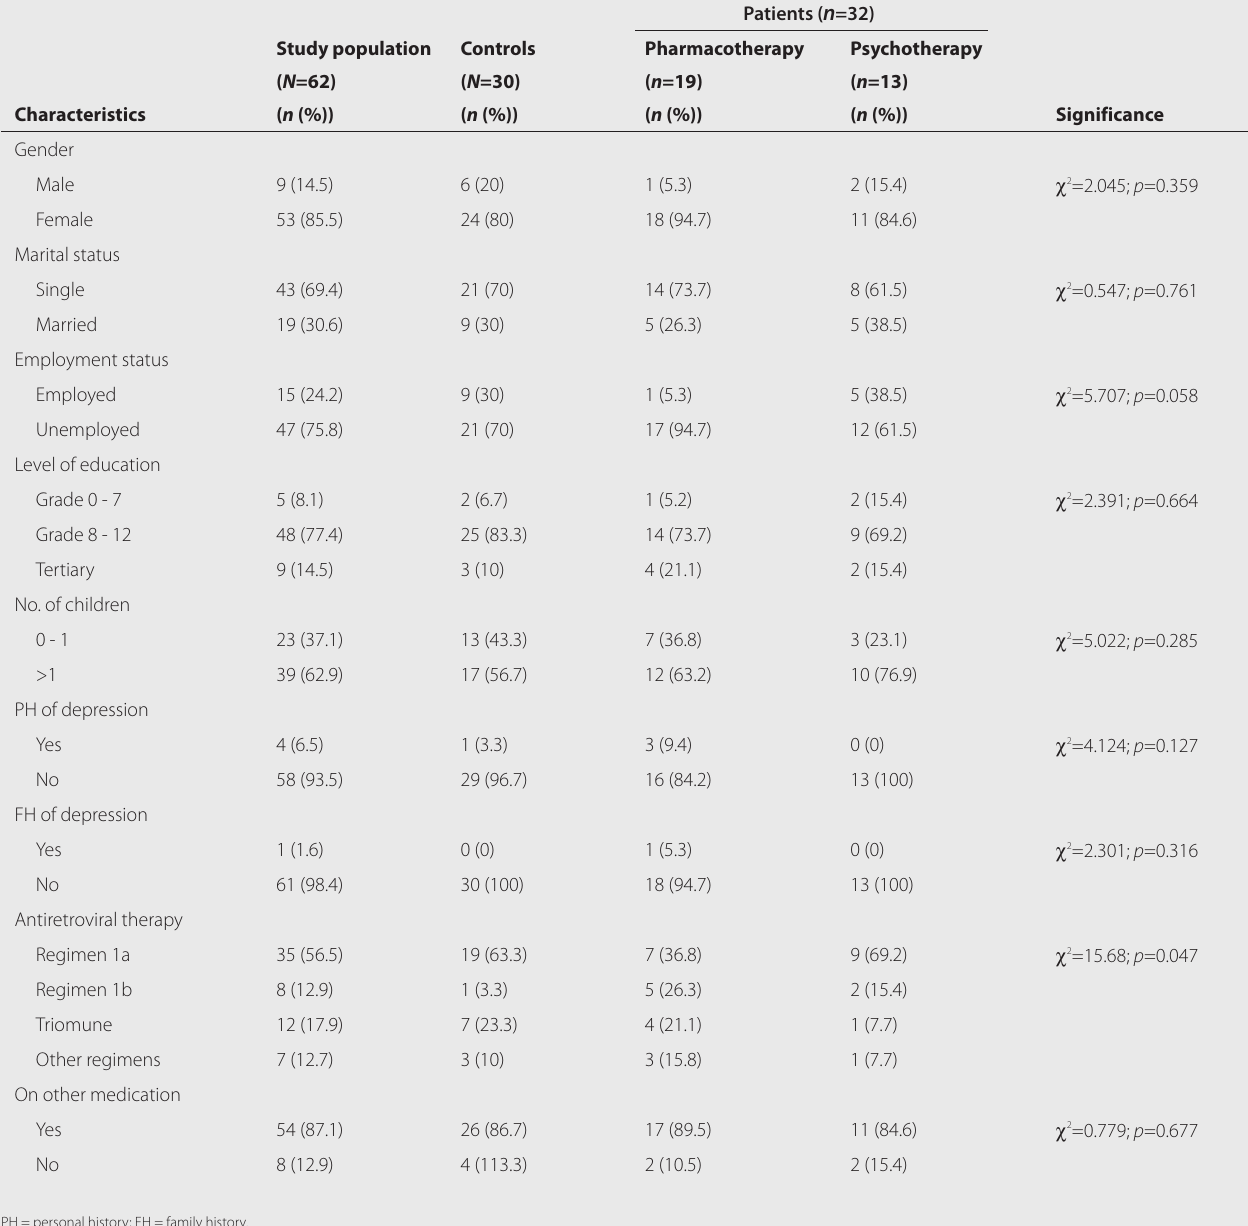
Table 1. Socio-demographic characteristics: comparisons between the depressed patients and the controls